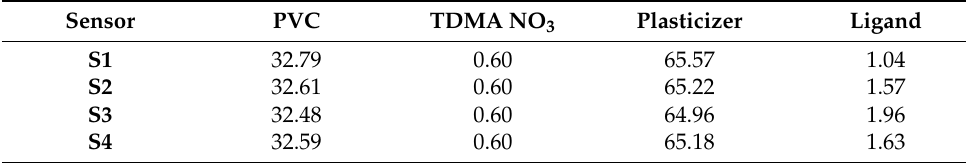
Table 2. Sensor membrane compositions (wt%).